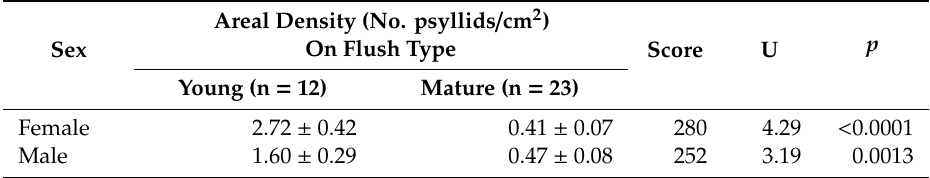
Table 2. Mean ± SE of female and male D. citri areal densities on young and mature